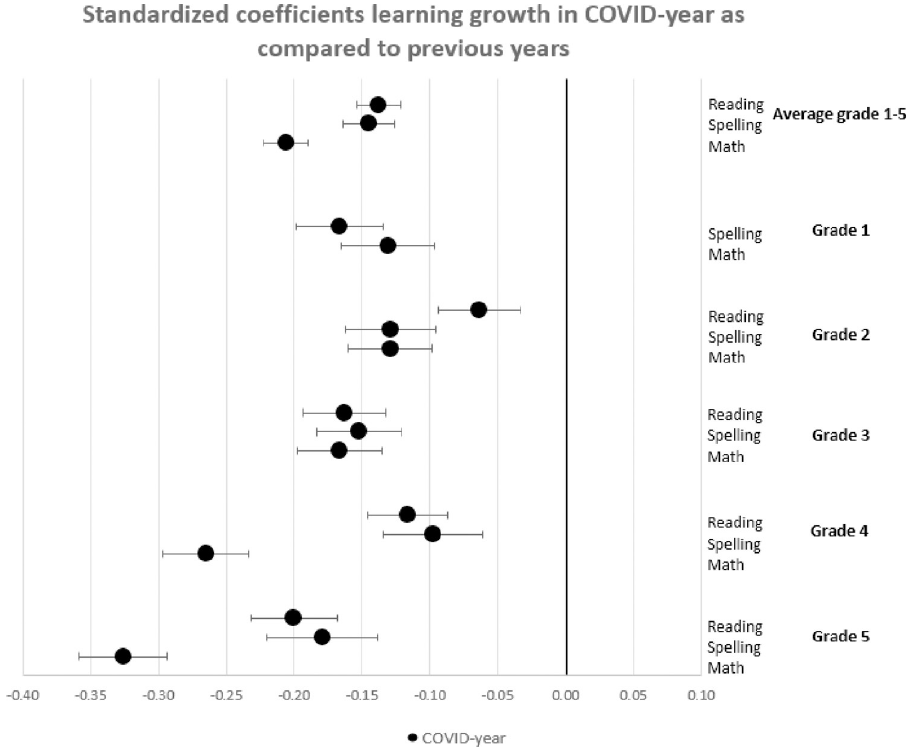
Fig 1. Standardized coefficients learning gains in COVID-19-year as compared to previous years (zero line).